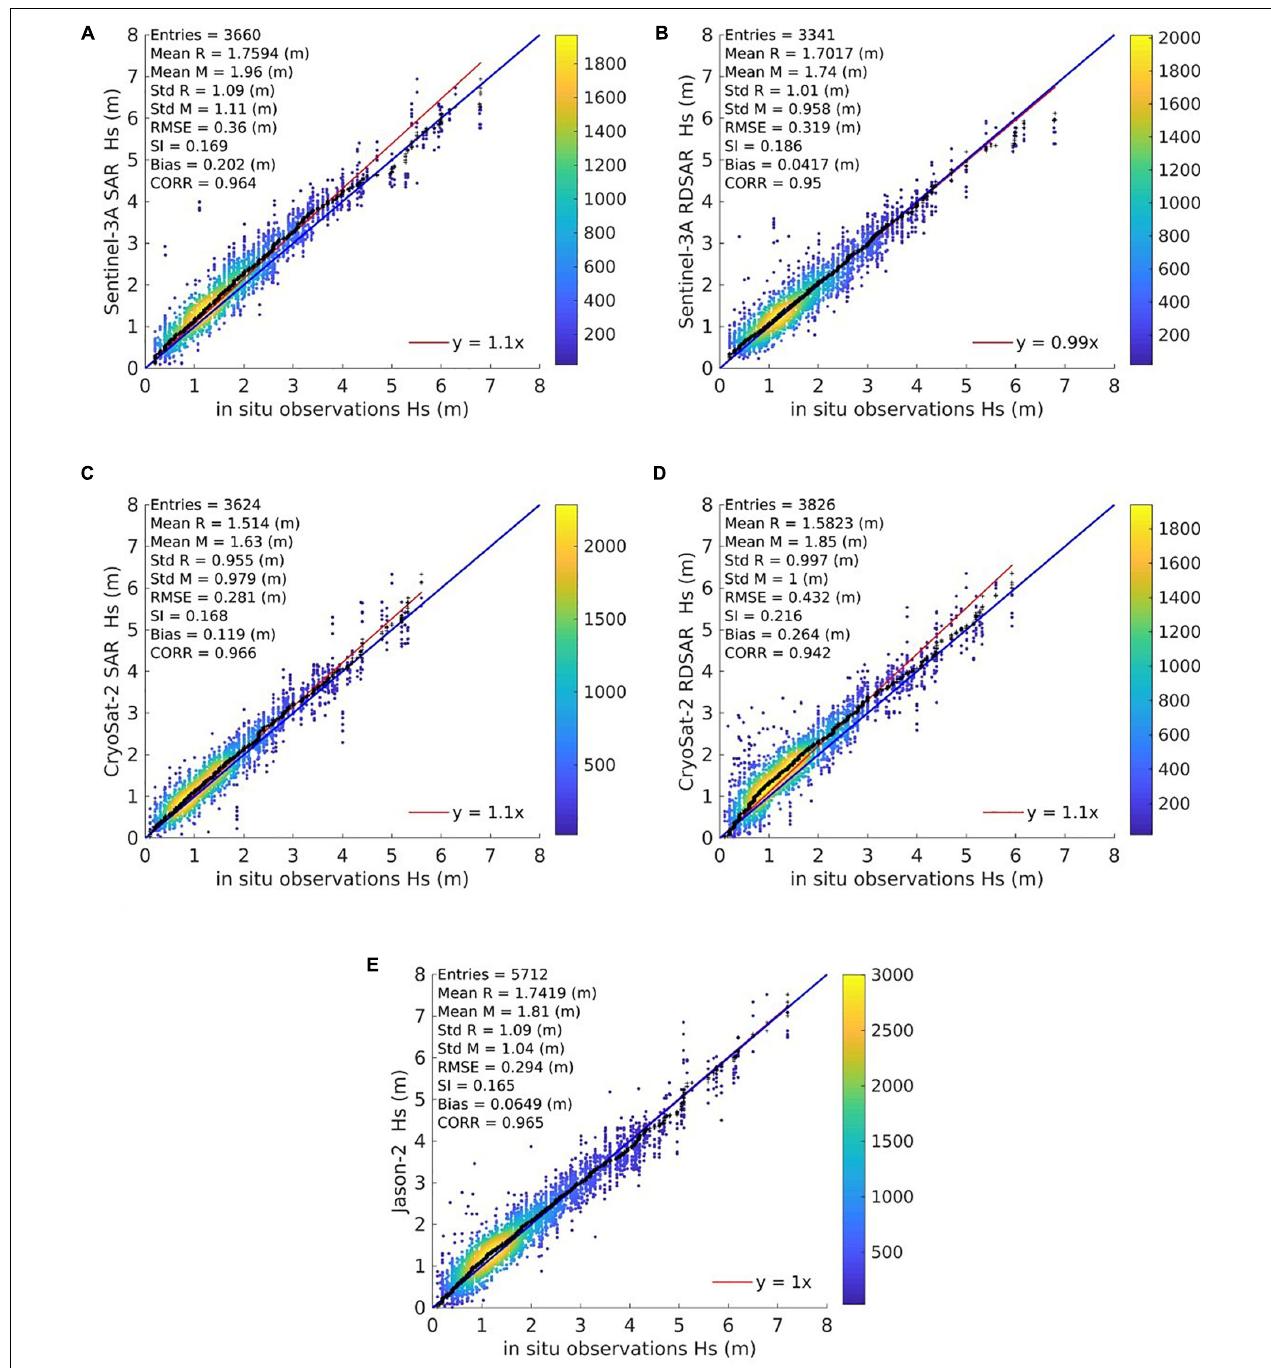
FIGURE 1 | QQ-Scatter plots of measured H S (in-situ GTS) versus remote sensing data from: (A) Sentinel-3A SAR, (B) Sentinel-3A RDSAR, (C) CryoSat-2 SAR, (D) CryoSat-2 RDSAR, and (E) Jason-2. The comparison is for the period June to November, 2016. The QQ-plot is indicated by black crosses, the 45 ◦ reference line by the blue line and the least-squares best fit line through the origin by the red